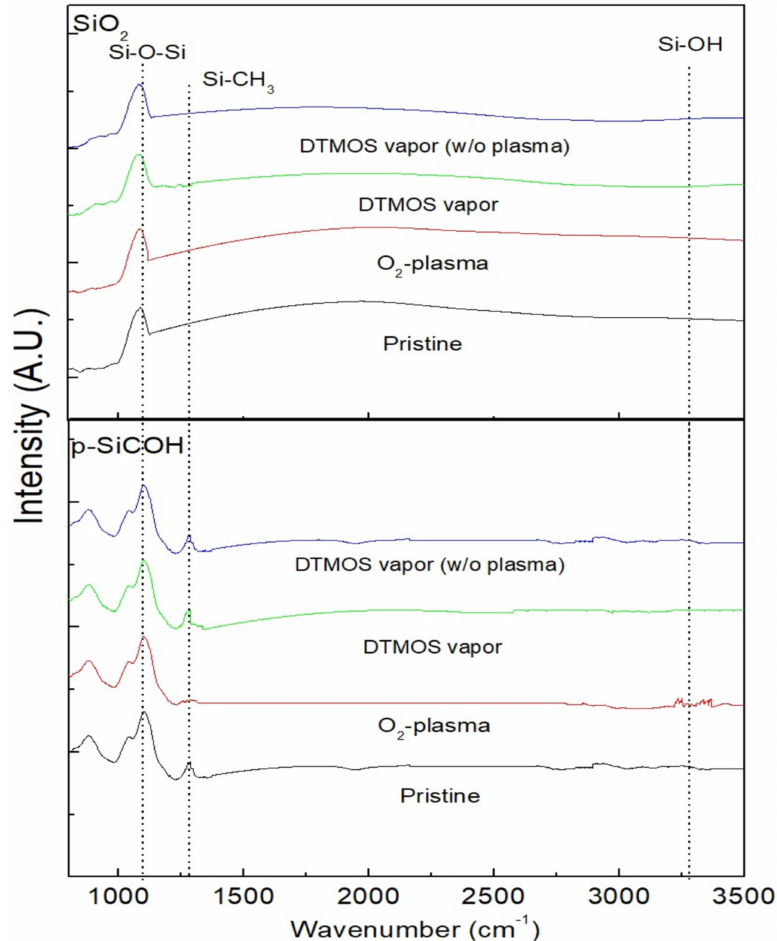
Figure 3. FT-IR spectra of SiO 2 and p-SiOCH films after O 2 plasma and DTMOS vapor treatments.